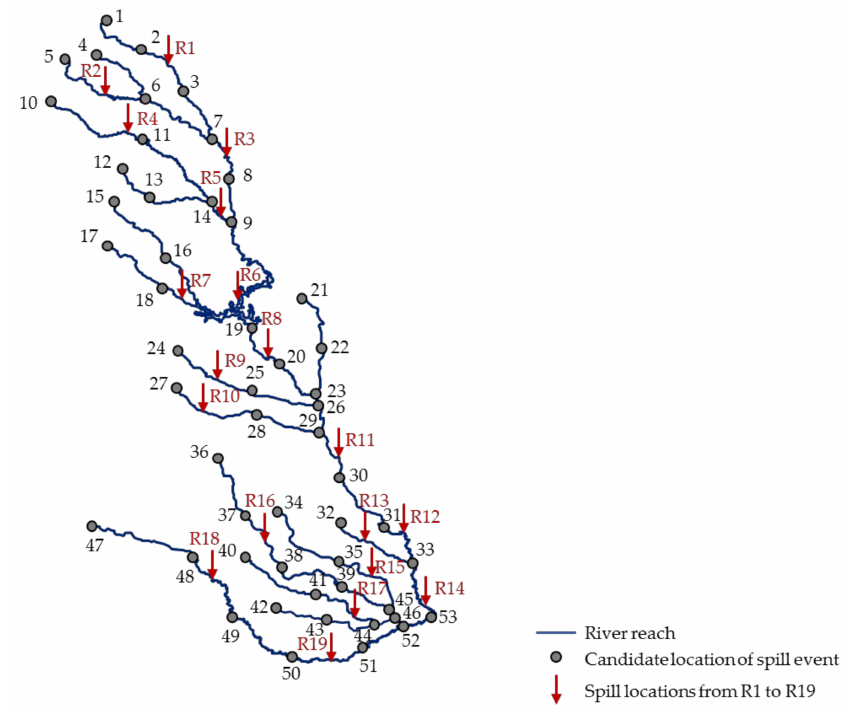
Figure 12. The 19 spill locations (from R1 to R19) near candidate locations